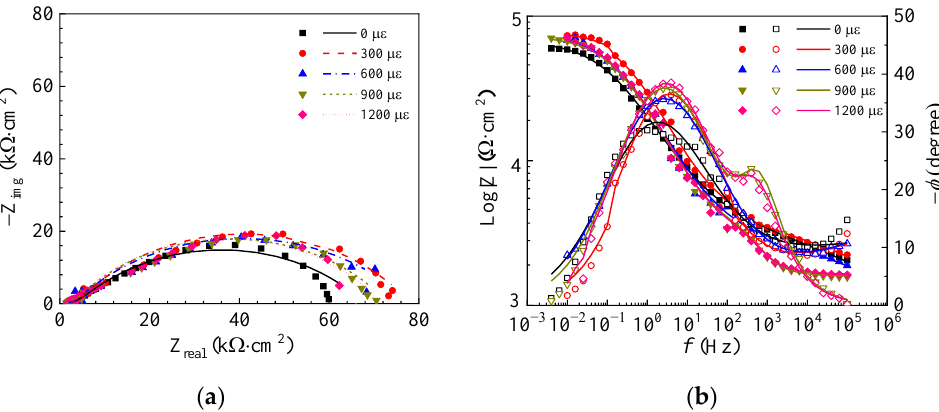
Figure 7. Equivalent electrical circuit: ( a ) uncoated steel rebar and ( b ) enamel-coated steel rebar.